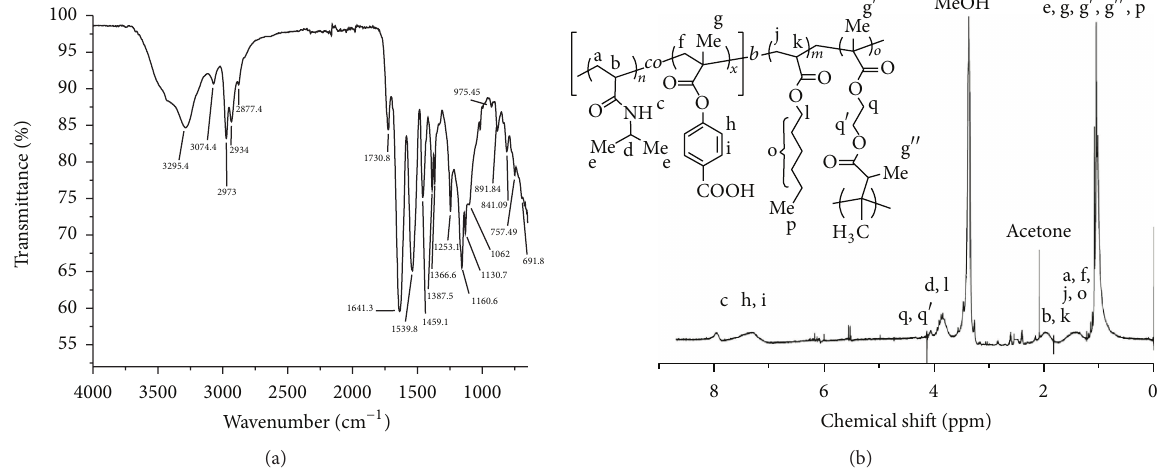
Figure 3: Spectra of star polymer [poly(NIPAAm- co -4MBA)- b -polyHA] 1 EGDMA10: (a) FT-IR spectrum, (b) 1H-NMR spectrum (MeOD).